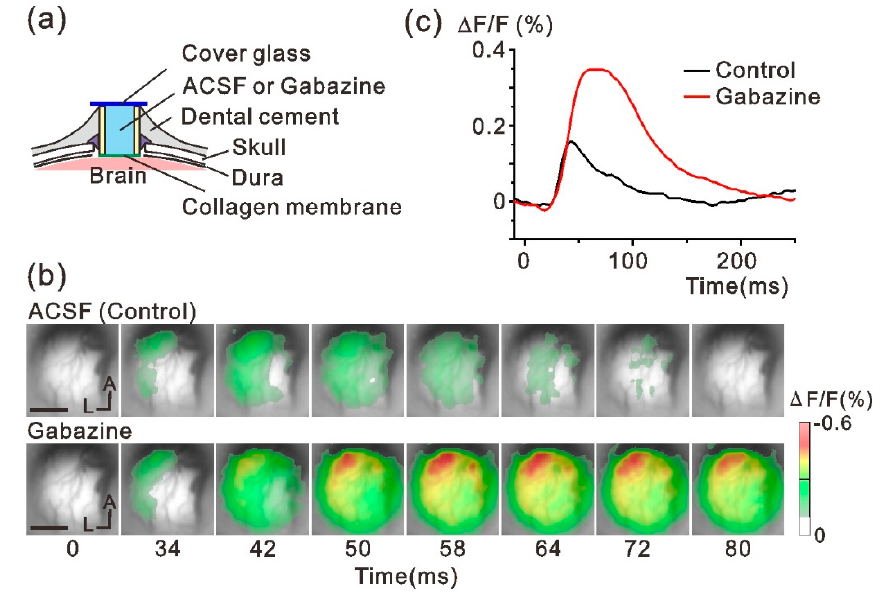
Figure 4. Pharmacological modulation of neuronal responses through the collagen membrane. ( a ) Schematic view of the experiment. The implanted tube device was filled with ACSF (control) or gabazine dissolved in ACSF. ( b ) Forelimb-evoked neuronal activity before (upper panels) and after administering gabazine (lower panels). ( c ) Representative time course of optical signals collected from the same brain regions before and after gabazine was administered. Scale bar in ( b ), 1 mm. A, anterior; L, lateral.